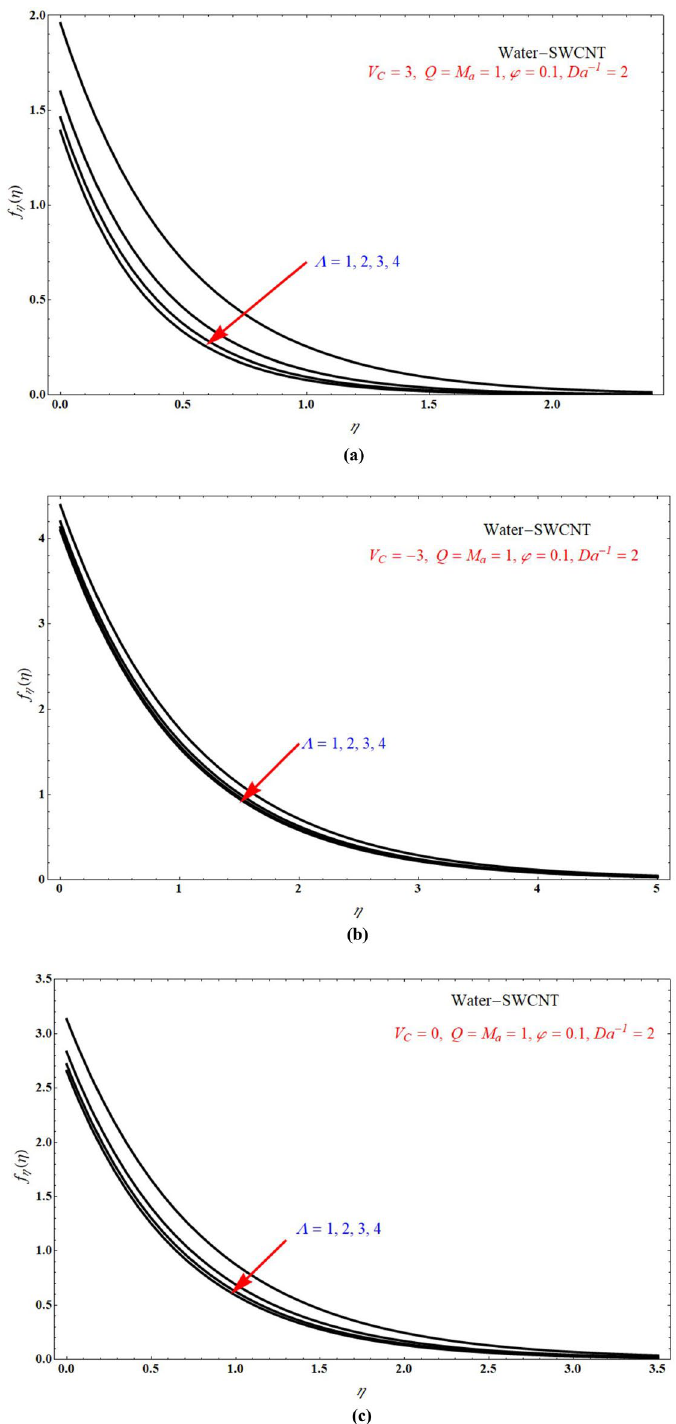
Figure 7. f η (η) verses η for various values of (cid:31) at ( a ) V C = 3 , ( b ) V C = − 3 and ( c ) V C = 0